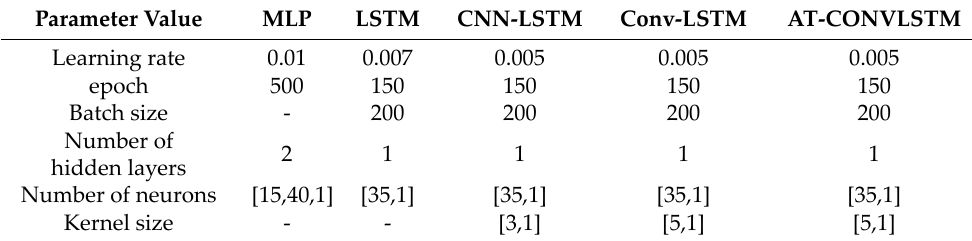
Table 4. Parameter settings for each network.